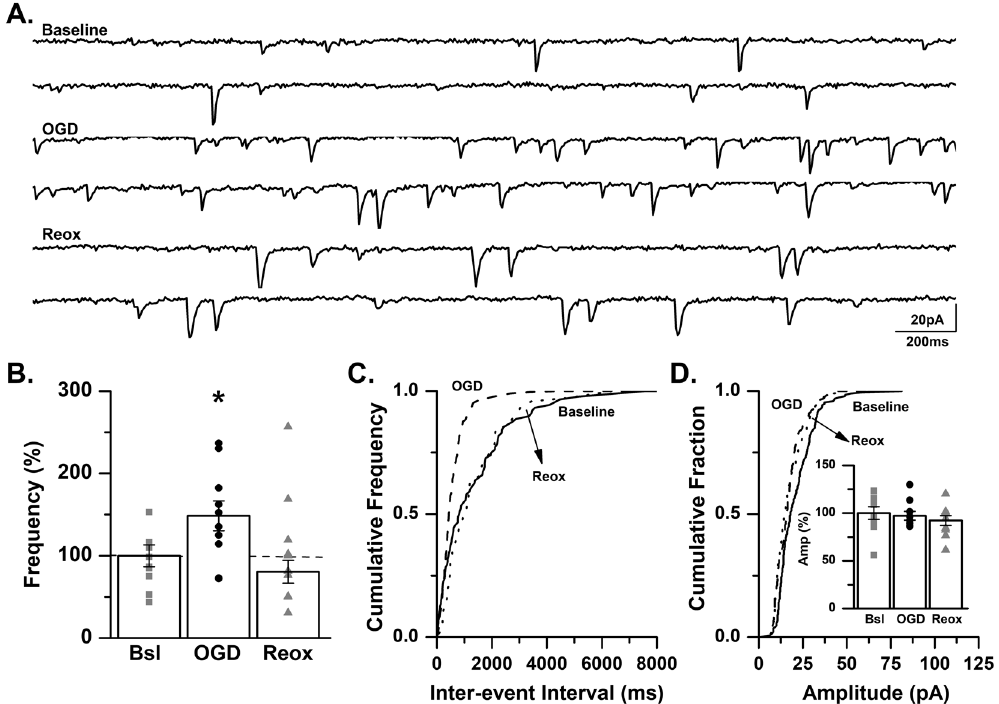
Figure 6. sEPSC frequency is significantly increased in CA3 pyramidal cells during OGD. ( A ) Representative traces from a control C57BL/6 mouse recorded at baseline, during OGD and during reoxygenation (reox) demonstrating an increase in spontaneous EPSC frequency during OGD. ( B ) Averaged data demonstrating that sEPSC frequency is significantly increased during OGD and returns to baseline levels during reox as a percent of baseline ( n = 10 cells, 6 animals; baseline, Bsl: 1.4 ± 0.18 Hz; OGD: 2.08 ± 0.25 Hz; reox: 1.13 ± 0.19 Hz). * p < 0.05, K-W ANOVA. Data presented as percent mean ± SEM. ( C ) Representative inter-event cumulative frequency histogram demonstrating a reduction in the inter-event interval during OGD. ( D ) Representative amplitude cumulative histogram demonstrating no change in mEPSC amplitude during OGD. Inset showing averaged data for sEPSC amplitude at baseline, during OGD and during reox. (baseline, Bsl: 17.06 ± 1.14 pA; OGD: 16.57 ± 0.77 pA; reox: 15.72 ± 0.88 pA). Data presented as percent mean ± SEM. Baseline, solid line; OGD, dashed line; reox, dotted